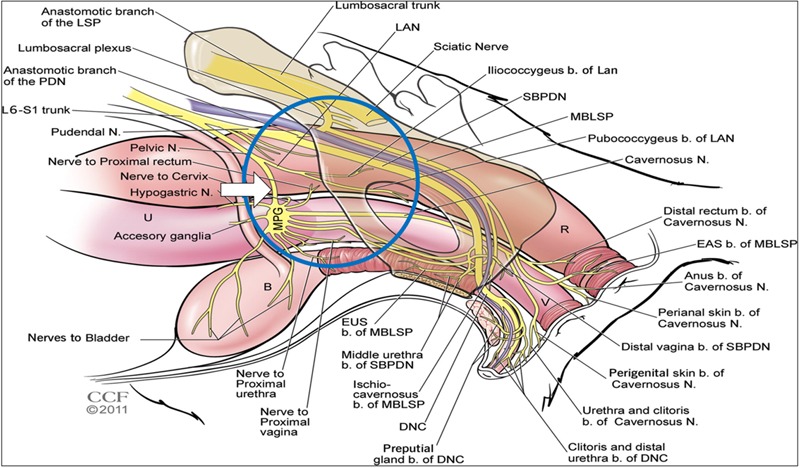
Diagram showing the anatomical arrangement of nerves innervating the pelvic viscera in the female rat. Blue circle shows area of interest. White arrow shows location of nerve cuff for stimulation. Reproduced from Pastelín et al. (2012) with permission from the copyright holder (John Wiley & Sons).